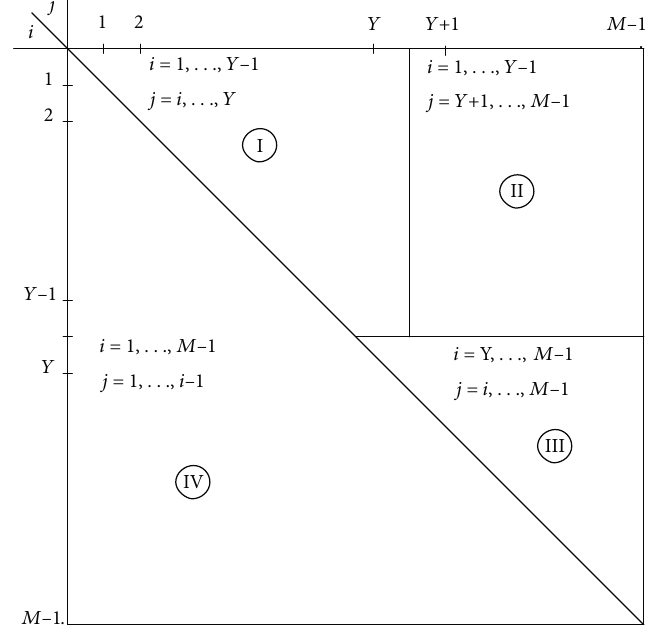
Figure 2: Birth process transition